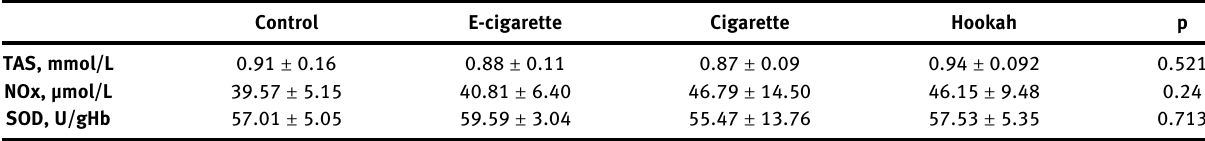
Table  : Some oxidant-antioxidant parameters measured in all groups (X ± SEM, n= 